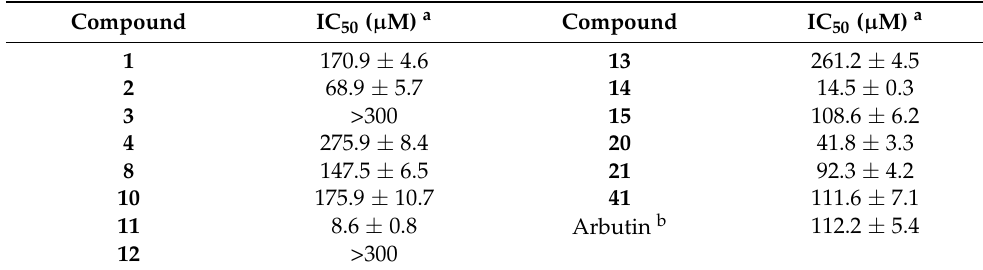
Table 3. Mushroom tyrosinase inhibitory effect of tested